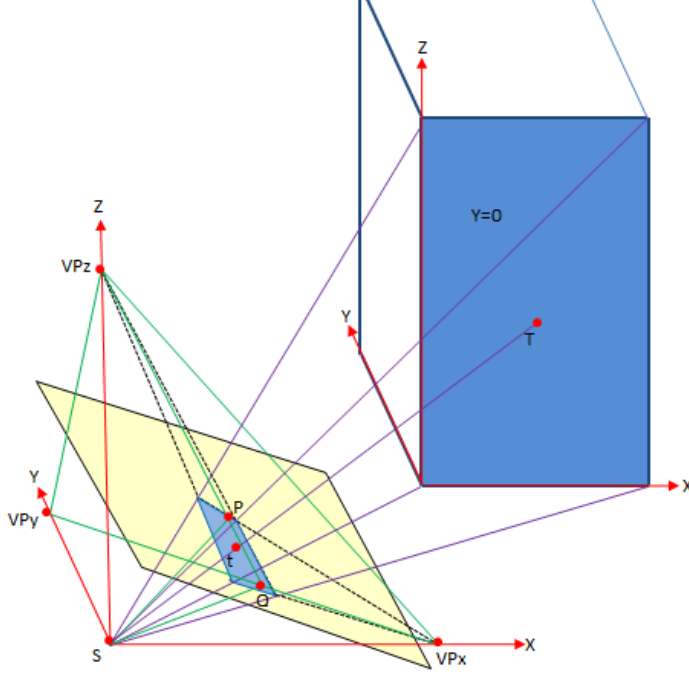
Figure 8. Dimensional analysis on a plane (in this case Y = 0 ) of the object and pseudo-3D modeling based on the rectification of the whole plane. The coordinates of any object point T can be computed from its image t , and the constraint Y collinearity